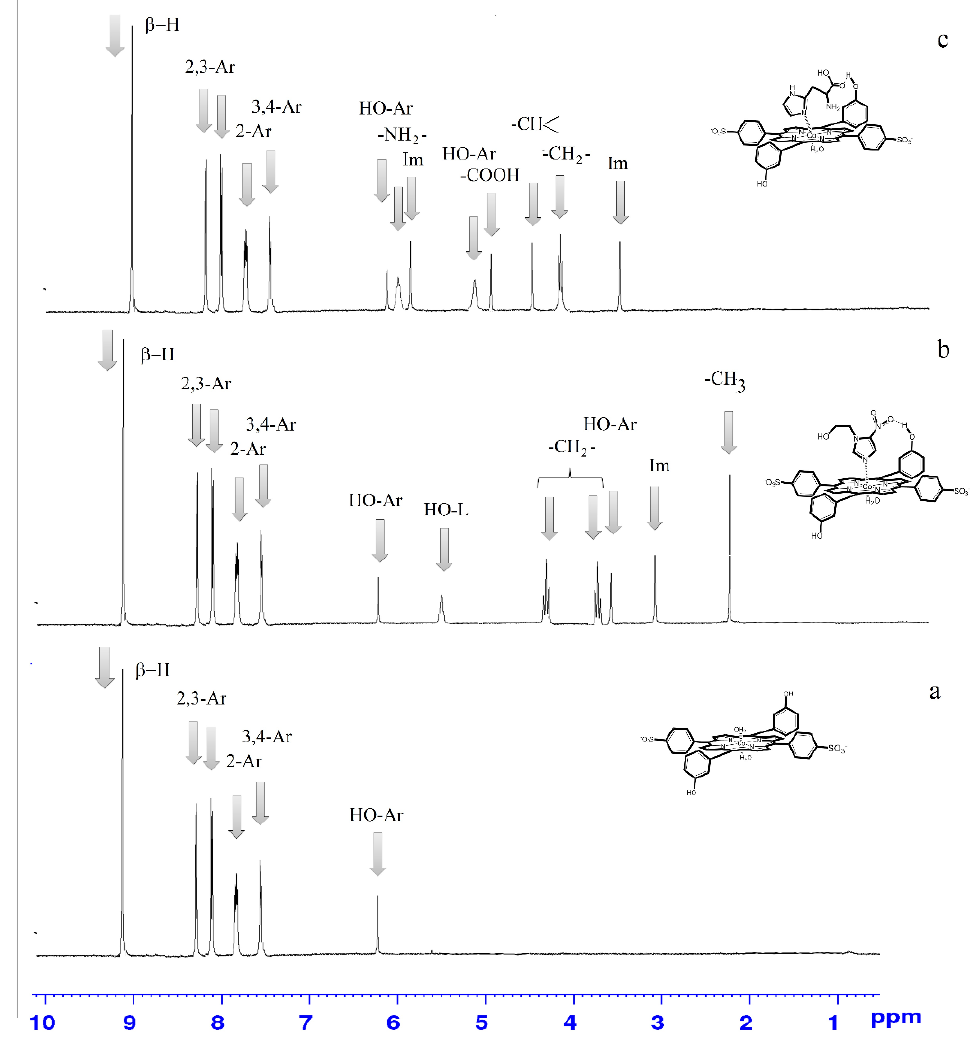
Figure 5. 1D-(part) of the 2D DOSY NMR spectra of the porphyrinate Co(III)P1(H 2 O) 2 ( a ), Co(III)P1(L 2 )(H 2 O) ( b ), and Co(III)P1(L 3 )(H 2 O) ( c ) in D 2 O/H 2 O, corresponding to the characteristic self-diffusion coefficient of these complexes.